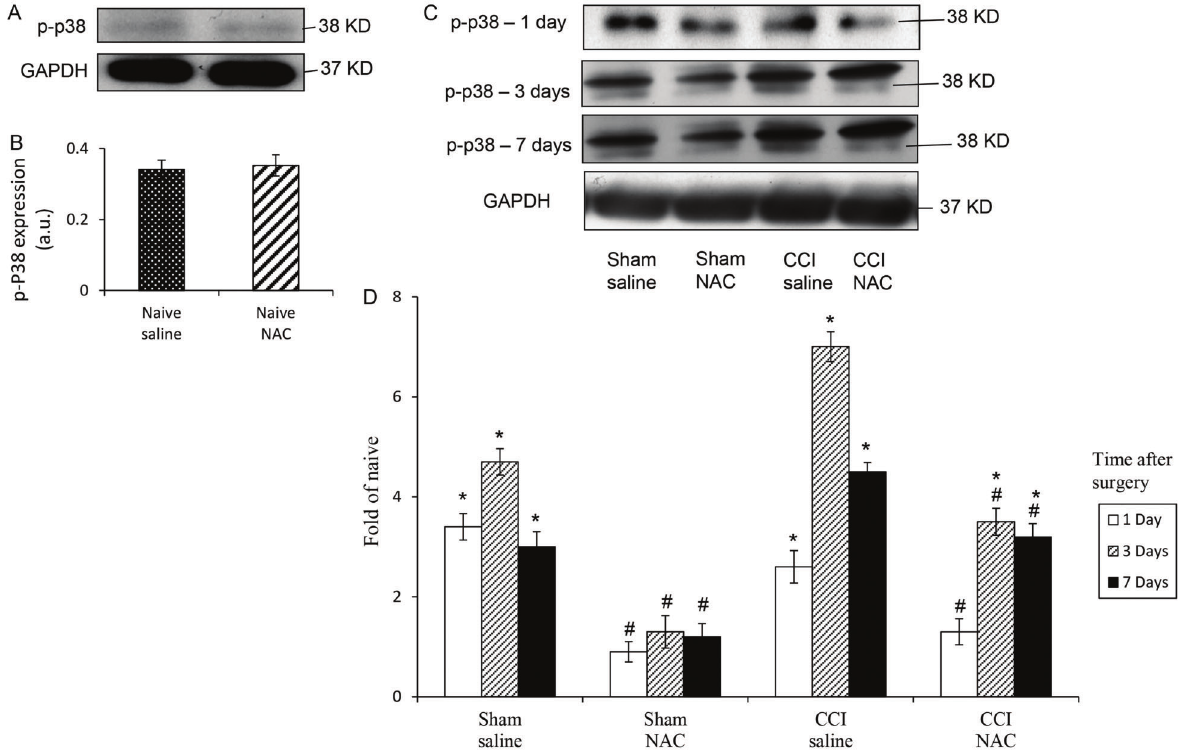
Figure 3. Phosphorylated p-38 (p-p38) expression in the spinal cord of rats with chronic constriction injury (CCI) of the sciatic nerve that received 2, 4 or 8 intraperitoneal injections of saline (vehicle) or N-acetylcysteine (NAC; 150 mg (cid:1) kg – 1 (cid:1) day – 1 ) beginning 4 h after CCI. Rats were sacri fi ced at 1, 3, and 7 days after surgery. Western blot bands ( A , C ) and a data summary ( B , D ) are shown. GAPDH served as loading control. Data are reported as means ± SE in arbitrary units (a.u.) or fold of Naive. *P o 0.05 compared to the Naive group at the same time-point. # P o 0.05 compared to the group that received only saline at the same time-point (three-way ANOVA followed by Tukey post hoc